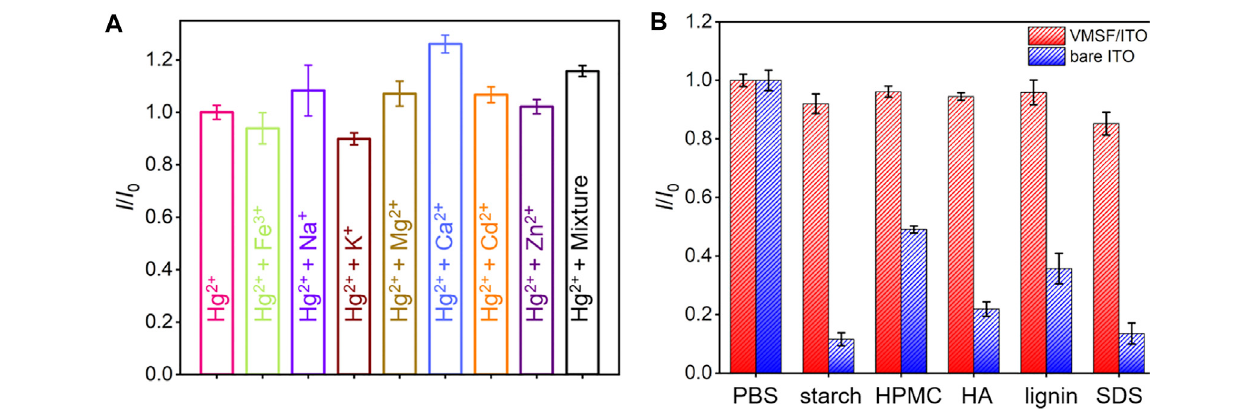
Frontiers in Chemistry |